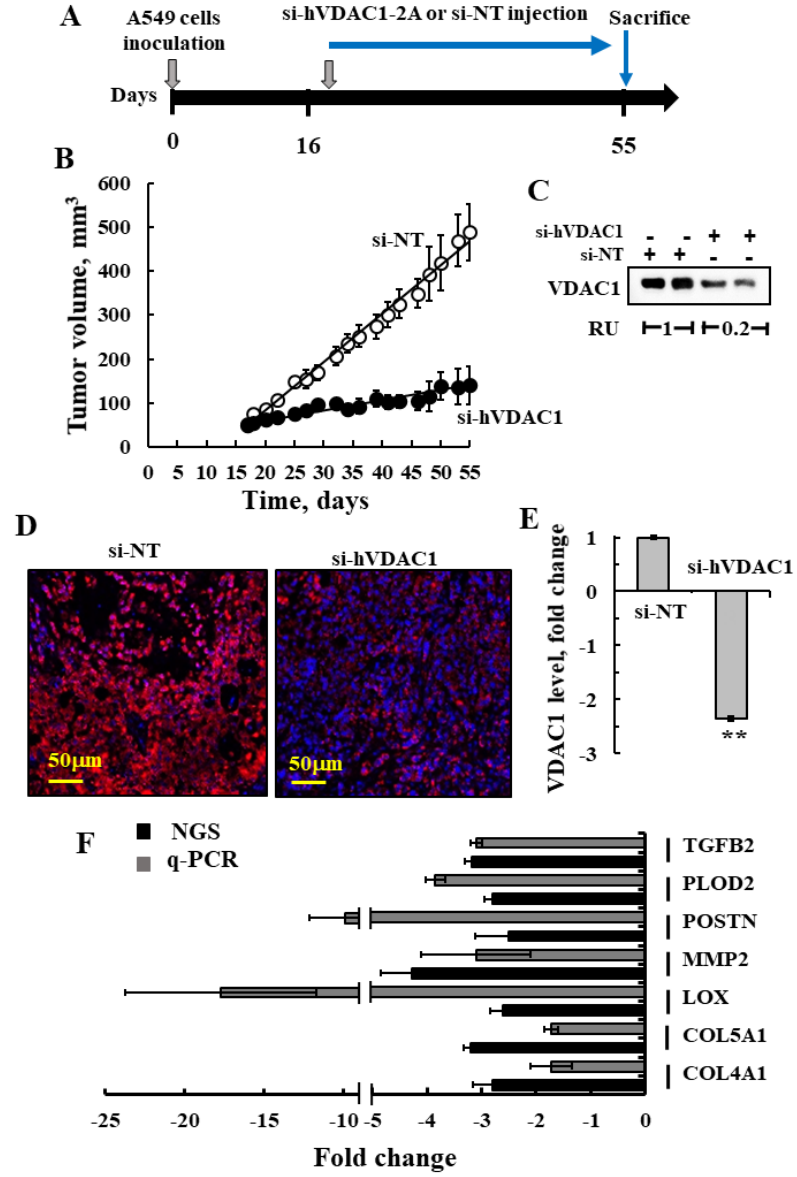
Figure 9. qRT-PCR validation of altered expression of selected TME-related genes. ( A ) Schematic presentation of the course of the experiment and peptide treatment initiation. ( B ) A549 cell-derived xenografts were established, and when tumor volume reached ~60 mm 3 , the mice were split into two groups and injected every 3 days with si ‐ NT or si ‐ hVDAC1 ‐ 2A (200 nM), and tumor volume was measured. ( B ) Tumors in the si ‐ NT ‐ treated group reached an average of 490 mm 3 at day 55 post ‐ cell inoculation, while tumors in the si ‐ hVDAC1 ‐ 2A ‐ treated group measured 140 mm 3 . Mice were sacrificed, and the tumors were excised and frozen in liquid nitrogen until used. ( C ) Tissue samples from excised tumors analyzed for VDAC1 levels by immunoblotting using anti ‐ VDAC1 antibodies with the relative expression levels (RU) are presented in the blot ( Figure S3 for uncropped Western Blot). ( D , E ) Representative staining of si ‐ NT ‐ TT and si ‐ hVDAC1 ‐ 2A ‐ TT sections with anti ‐ VDAC1 antibodies with confocal images ( D ) and quantitative analysis of the fluorescence intensity ( E ) are shown. The results are the means ± SD, ** p ≤ 0.01. ( F ) The fold of change in the expression level of selected proteins was analyzed by q ‐ PCR (gray bars), and data obtained from the NGS analysis (black bars) are presented. RNA isolation and qPCR of key TME genes using mouse ‐ specific primers (Table S2) were performed as described in Section 2.